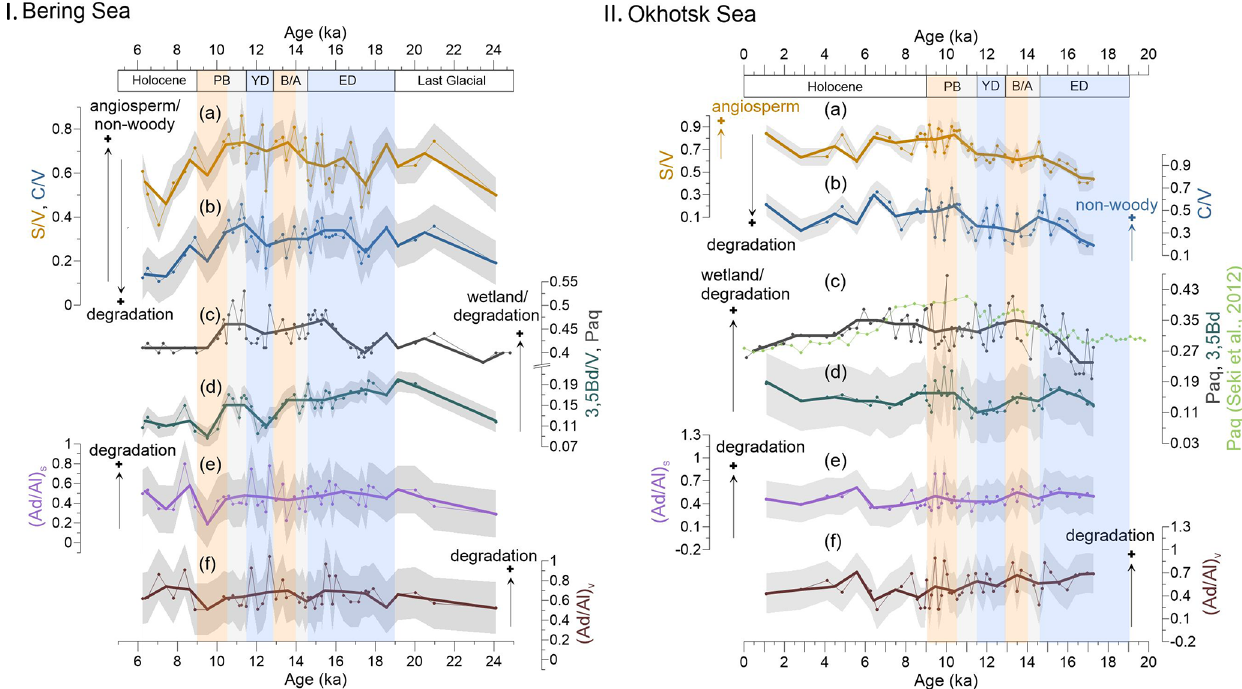
Figure 4. Records of lignin and non-lignin phenol indices compared with the Paq index in Bering Sea (I) and Okhotsk Sea (II) sediments. (a, b) S / V and C / V ratios reflect the vegetation change and/or degree of lignin degradation in the respective river basins. (c, d) 3 , 5Bd / V and Paq ratios represent the wetland extent or degree of degradation in the respective catchments. In panel II , showing records from the Okhotsk Sea, the light-green line represents the Paq of a nearby core, XP07-C9 (Seki et al., 2012). (e, f) The Ad / Al can reflect the degradation of lignin phenols. Shaded gray areas illustrate the uncertainty in these indices. Bold lines are the 1kyr averages of the corresponding indices. Blue boxes represent the cold spells the early deglaciation (ED) and Younger Dryas (YD); orange boxes are for the warm phases Bølling– Allerød (B/A) and Pre-Boreal (PB). Gray boxes highlight the periods of meltwater pulse 1A (MWP-1A) and 1B